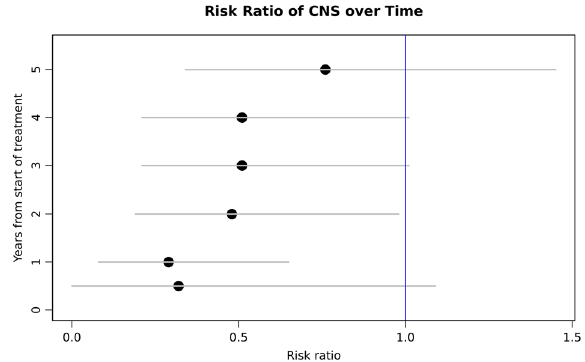
Fig. 3 Risk ratio of CNS relapse with and without prophylaxis over time.